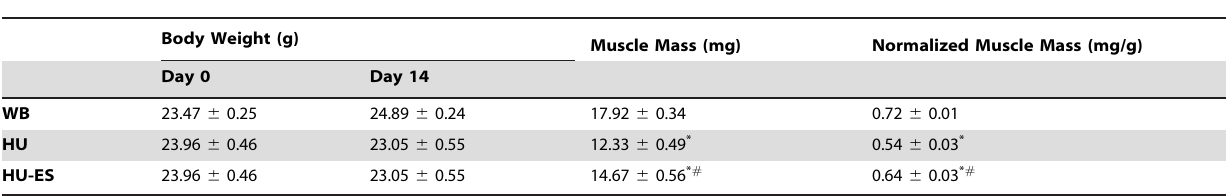
Table 1. Body weight and muscle mass.